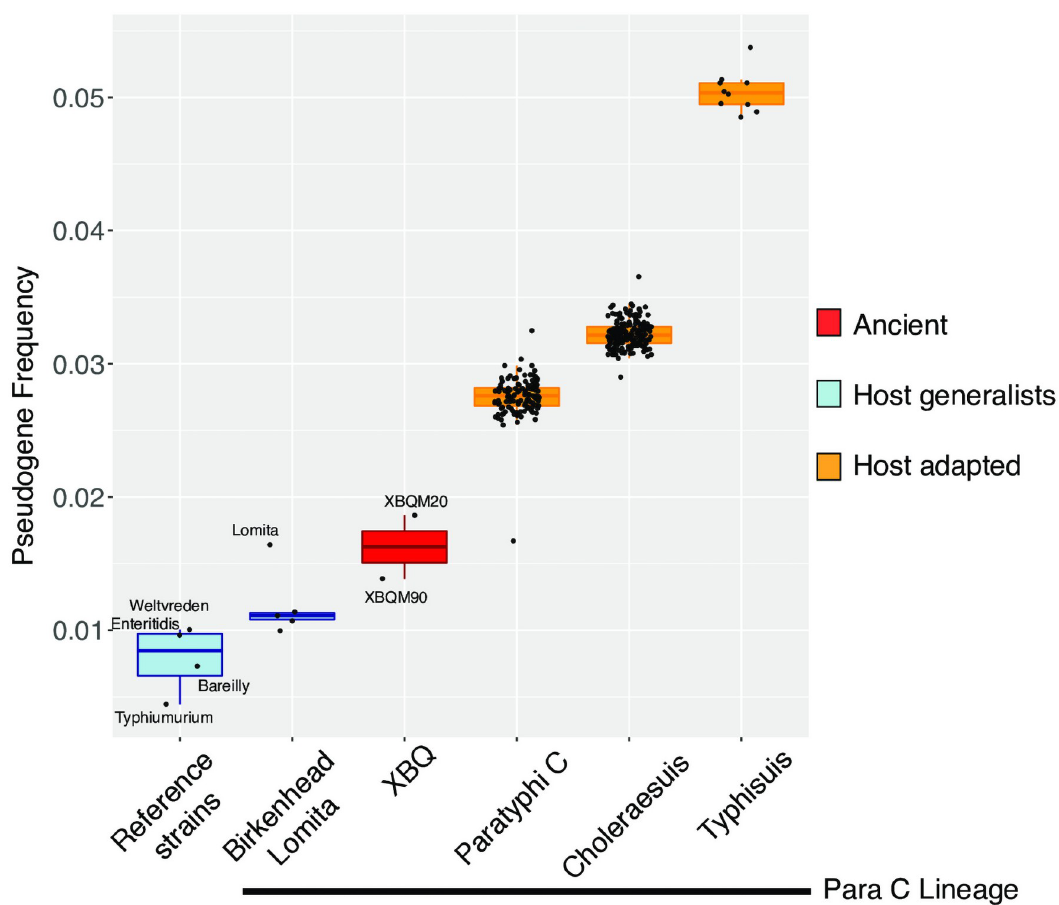
Fig 5. Pseudogene frequency of reference strains, XBQ samples, and strains from the Para C lineage. Relative frequency of pseudogenes for known host generalists (blue), ancient XBQ samples (red), and known host adapted strains part of the Para C Lineage (orange). XBQ genomes with genome-wide coverage above 3X were included. Included reference strains (incl. BioSample identifier) not part of the Para C lineage are: Typhimurium (SAMN03996249), Weltevreden (SAMEA1904377),